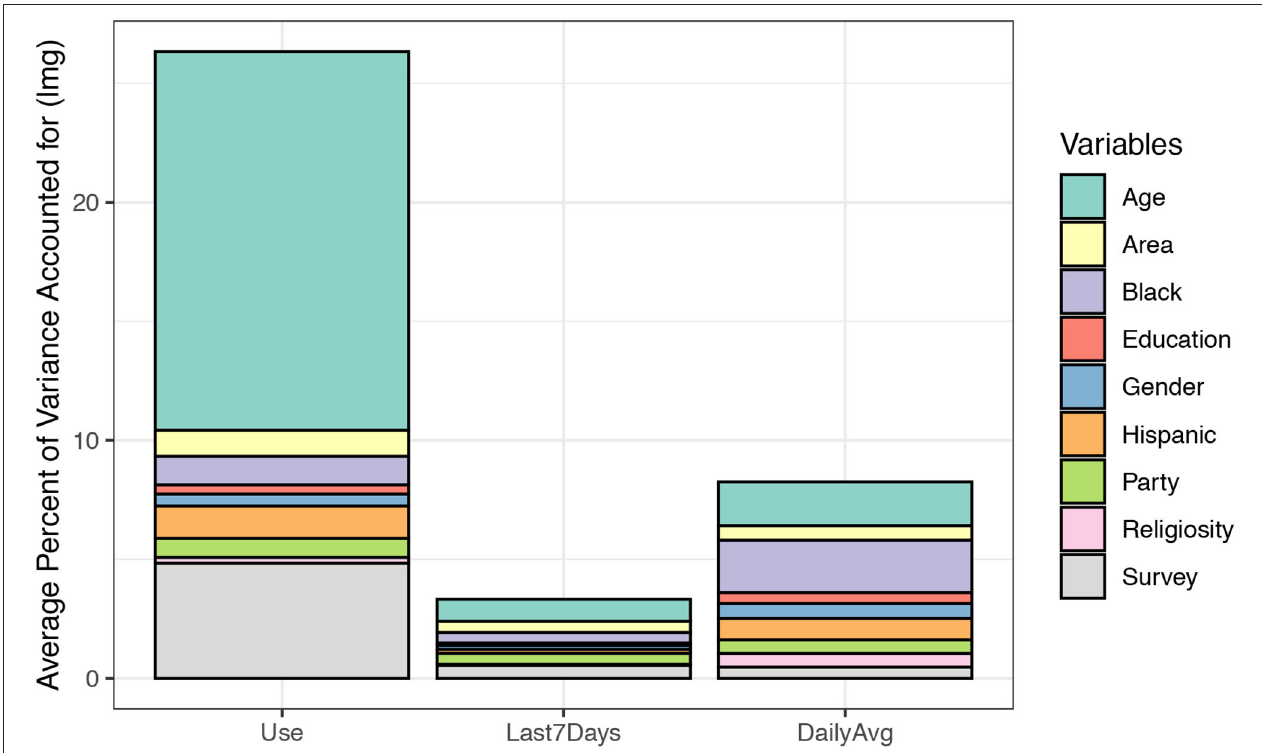
FIGURE 3 | Relative importance of each of the individual difference variables. Age is the most important factor included in the model. Any effects of gender are negligible compared to the influence of age on frequency of YouTube use.